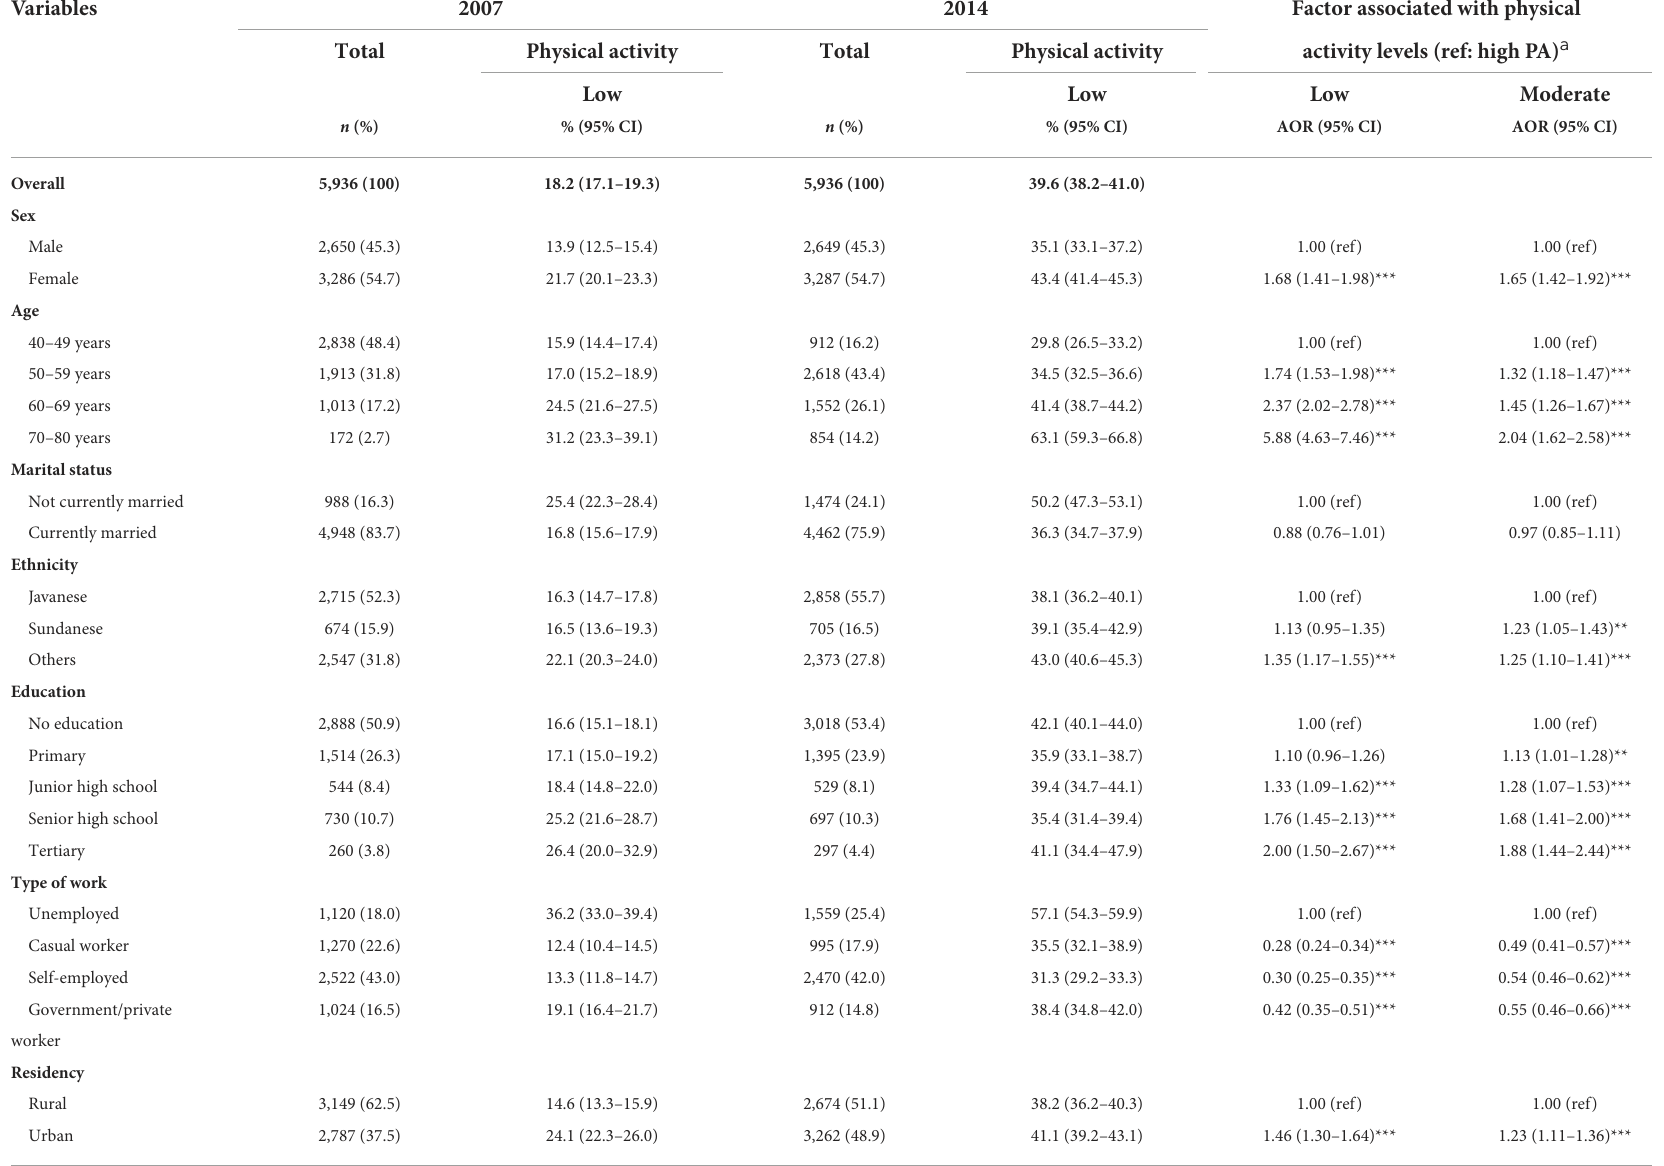
TABLE 2 Prevalence of low physical activity and factor associated with physical activity